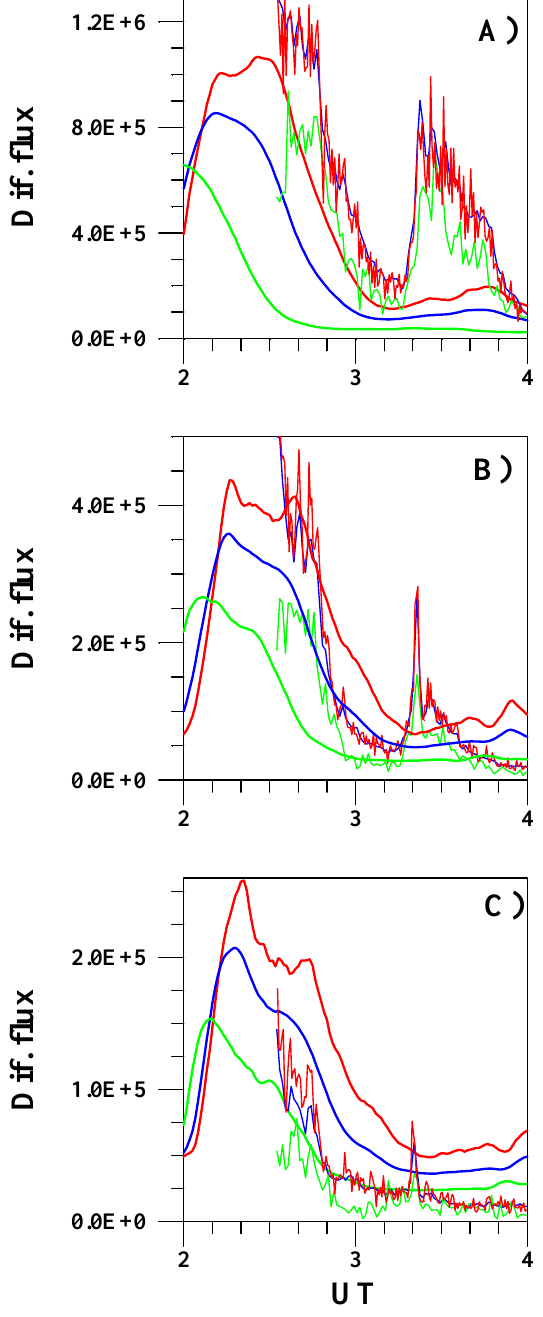
Fig. 9. Differential fluxes along (green) and across (red) the geo- magnetic field and omnidirectional fluxes (blue) within the energy channels 21.5–31.5keV (A) , 31.5–40.0keV (B) , and 40.0–49.5keV (C) . The fluxes detected by the CRRES satellite are shown by the thin line. Results of tracing of the fluxes, detected by the LANL- 097 satellite to the longitude of the CRRES satellite, are shown by the bold